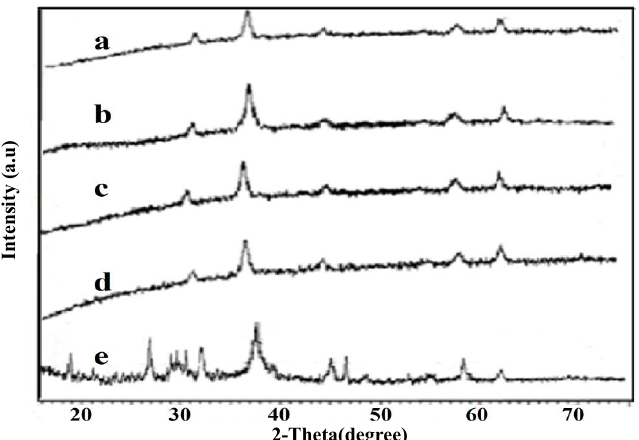
Fig. 2. XRD pattern of (a) bare magnetite, (b) magnetite-citric acid, (c) magnetite-salicylic acid, (d) magnetite-starch and (e) magnetite-clinoptilolite Fig.